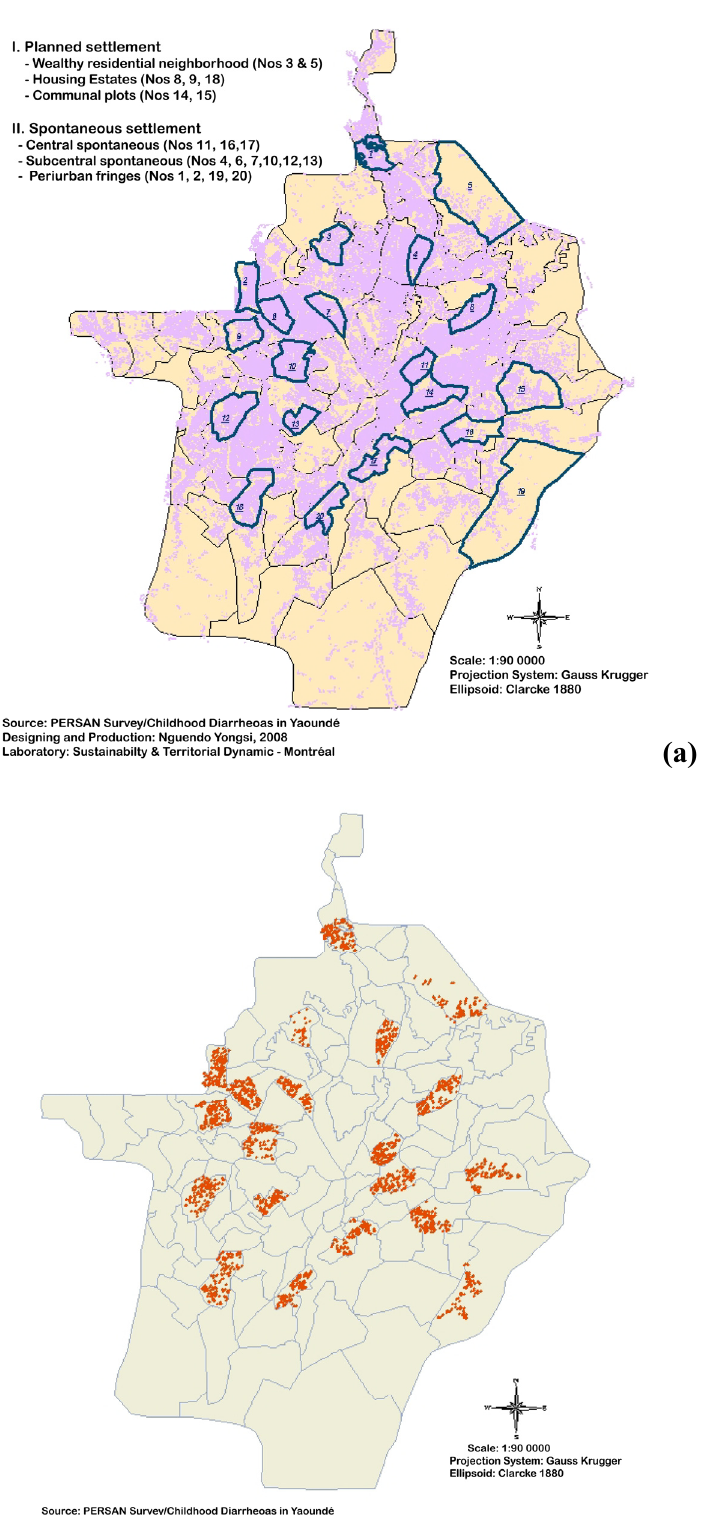
Processing of samples: (1) Bacteriology: After reception, stool samples were cultured in various solid selective media and selenite broth. Plates were incubated for 18 hours at 37°C, except for Campylobacter medium which was incubated 48 hours at 42°C under microaerophilic